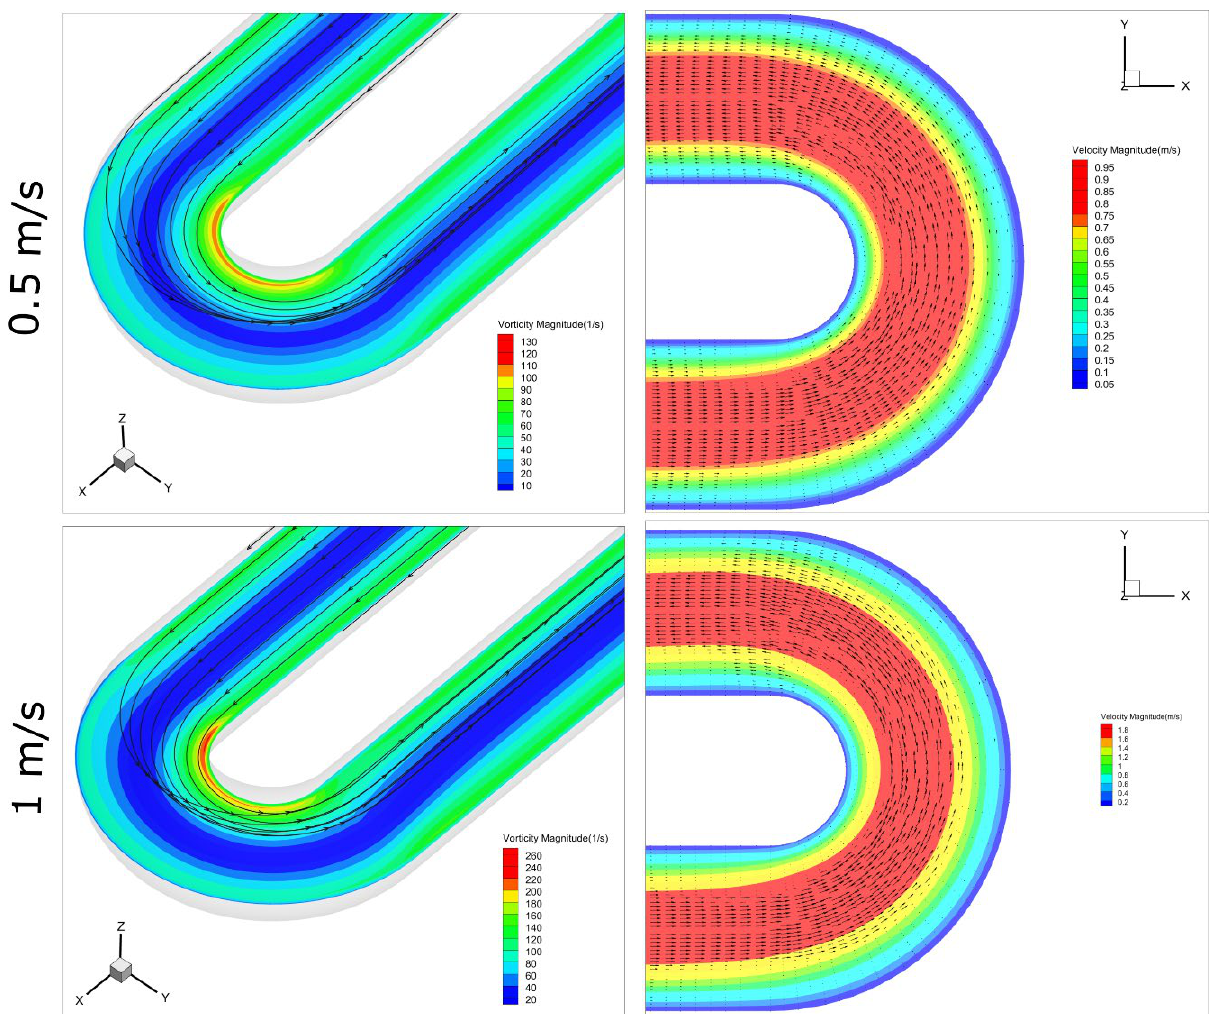
Figure 9. The pressure and the vorticity magnitude at the middle-height plane of the U-shaped channel. The pressure is displayed in the left column, and the vorticity magnitude is displayed in the right column. The upper row shows the data at the inlet velocity of 0.5 m/s at the temperature conditions of 283 K on the wall and 300 K of the incoming fluid at the inlet. The lower row shows the results at the inlet velocity of 1 m/s at the temperature conditions of 283 K on the wall and 300 K of the incoming fluid at the inlet.